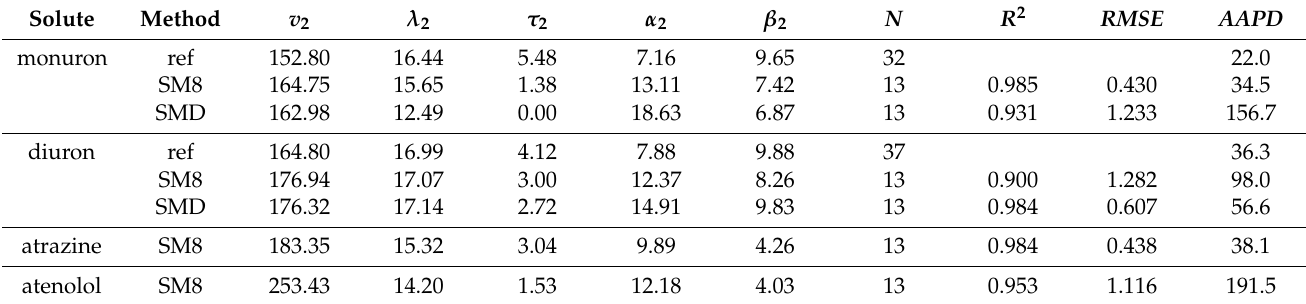
Table 1. The MOSCED parameters for the studied solutes obtained using reference data generated using molecular simulation free energy calculations at 298.15 K. For all cases we consider partial atomic charges obtained using the SM8 solvation model. For monuron and diuron we additionally considered partial atomic charges obtained using the SMD solvation model, and we list MOSCED parameters regressed in ref. [12] obtained from experimental solubility data (ref). v 2 has units of cm 3 /mol, and λ 2 , τ 2 , α 2 , and β 2 all have units of (J/cm 3 ) 1/2 . For all the solutes, q 2 = 0.9. N corresponds to the number of reference data used to regress the parameters, and R 2 , RMSE , and AAPD are the resulting coefficient of determination, root mean squared error, and average absolute percent deviation, respectively. The statistics for the reference parameters for monuron and diuron were taken from ref.